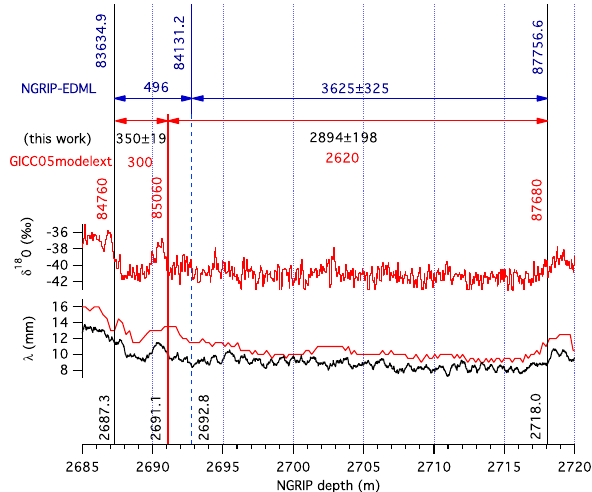
Fig. 3. Comparison of NorthGRIP ice core chronologies over the interval between GI-21 and GI-22. Also shown are NGRIP δ 18 O ice and annual layer thicknesses ( λ) from the ss09sea06bm ice-flow model and from annual layer counting (this study). Numbers shown horizontally correspond to event durations in years calculated from GICC05modelext in red (Wolff et al., 2010), NGRIP-EDML gas - synchronized chronology in blue (Capron et al., 2010b) and annual layer counting in black (this study). Vertical numbers show NGRIP depths (black) corresponding to absolute ages in years before 2000AD from GICC05modelext (red) and EDML-synchronized NGRIP (blue)